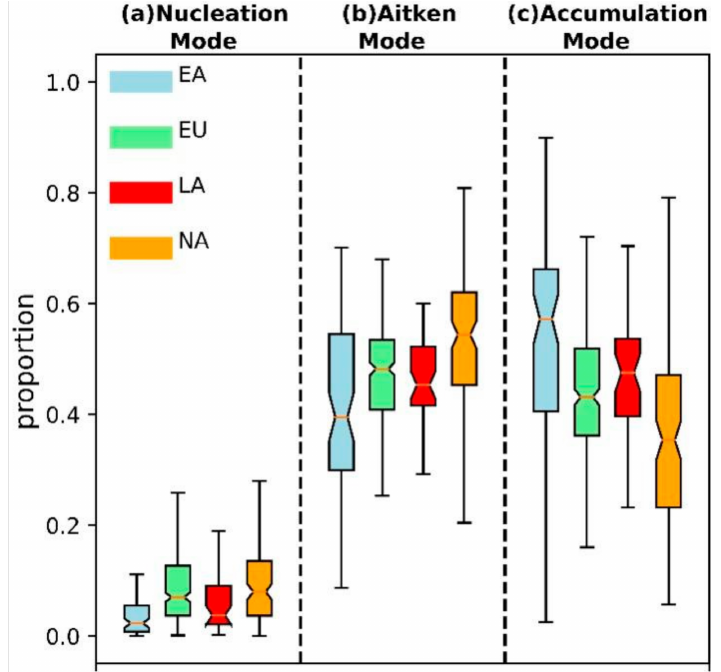
Figure 3. Proportion of the three modes of aerosol number concentration in the four regions. The proportion of ( a ) nucleation mode aerosols, ( b ) Aitken mode aerosols, and ( c ) accumulated modal